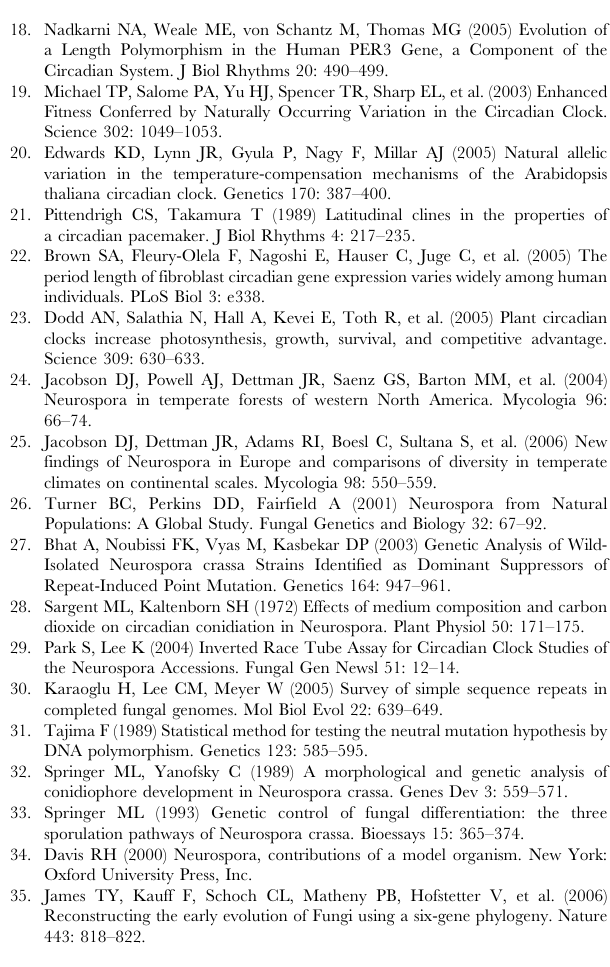
respective domains. Choice of accessions, sequencing and alignment in Clustalx are described in Experimental procedures. Figure S4 Variation in VVD. VVD protein sequence deduced from the sequence of N. crassa accessions FGSC # 2227, 6421, 87-3 (a reference strain), 4826, 4832, 3972, 3974, 3970, and 4819. Phylogenetic tree of VVD proteins across accessions was created using ClustalW alignment in MegAlign DNASTAR Lasergene 6 software suite with default settings. Choice of accessions, sequencing and alignment in Clustalx are described in Exper- imental procedures. Found at: doi:10.1371/journal.pone.0000795.s004 (2.50 MB TIF) Figure S5 Variation in FRQ. FRQ protein sequence deduced from sequencing N. crassa accessions FGSC # 3974 and sequenced lab strain 74a (FGSC # 2489). Choice of accessions, sequencing and alignment in Clustalx are described in Experimental procedures. Found at: doi:10.1371/journal.pone.0000795.s005 (2.50 MB TIF) Table S1 N. crassa genotypes, circadian phenotypes and latitudes of collection. *Rhythmicity Index; 1: arrhythmic, no rhythmic banding phenotype, 2: only the first peak after transferred to a constant condition but no clear peak after that peak, 3: rhythmic banding, first peak is pronounced while other peaks are weak, 4: rhythmic banding, no pronounced first peak, 5: robust rhythmic banding FGSC # : fungal genetics stock number; mat: mating type;